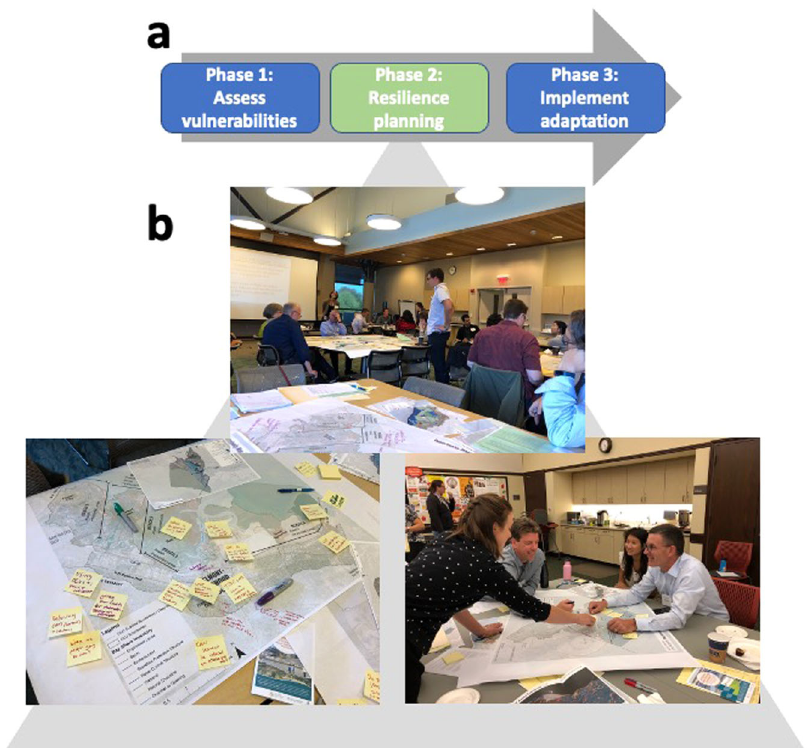
Fig. 4 The engagement process. We conducted this work in conjunction with the County of San Mateo ’ s Of fi ce of Sustainability and their broader sea-level rise planning efforts, which includes three phases ( a ). This work was part of the second phase of that effort, going from information about vulnerabilities to the exploration of adaptation options. In partnership with the County, we participated in several stakeholder meetings ( b ) to help create the guiding principles to shape adaptation options and scenarios, to get feedback on the suitability of nature-based solutions, and to share results comparing ecosystem services delivered by different adaptation